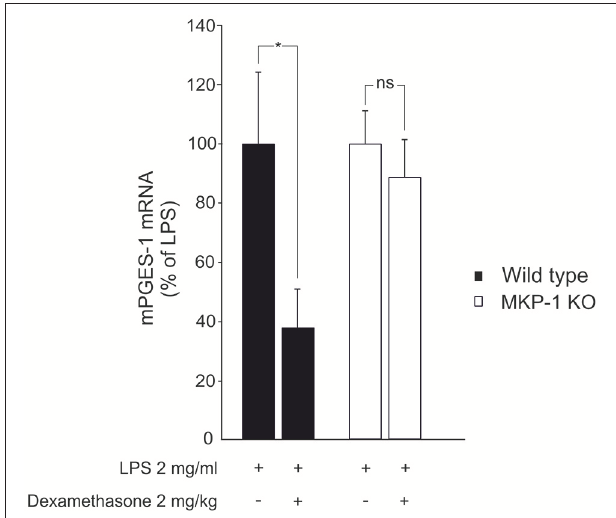
FIGURE 2 | Dexamethasone inhibits mPGES-1 expression in acute inflammatory response in vivo in an MKP-1 dependent manner. Dexamethasone (2 mg/kg) was given intraperitoneally an hour before LPS (50 µ l of 2 mg/ml in PBS) was injected into the hind paw of anesthetized mice to induce acute inflammation. The paw tissues were collected 6 h after the LPS injection and mPGES-1 mRNA levels were measured by quantitative RT-PCR and normalized against GAPDH mRNA levels. Results are expressed in arbitrary units, mPGES-1 mRNA levels in LPS treated paw tissue from wild-type mice were set as 100% and the other values are related to that. Results are expressed as mean + SEM, n = 6–8. One-way ANOVA with Bonferroni’s post-test was performed and statistical significance is indicated as * P < 0.05 and ns = not